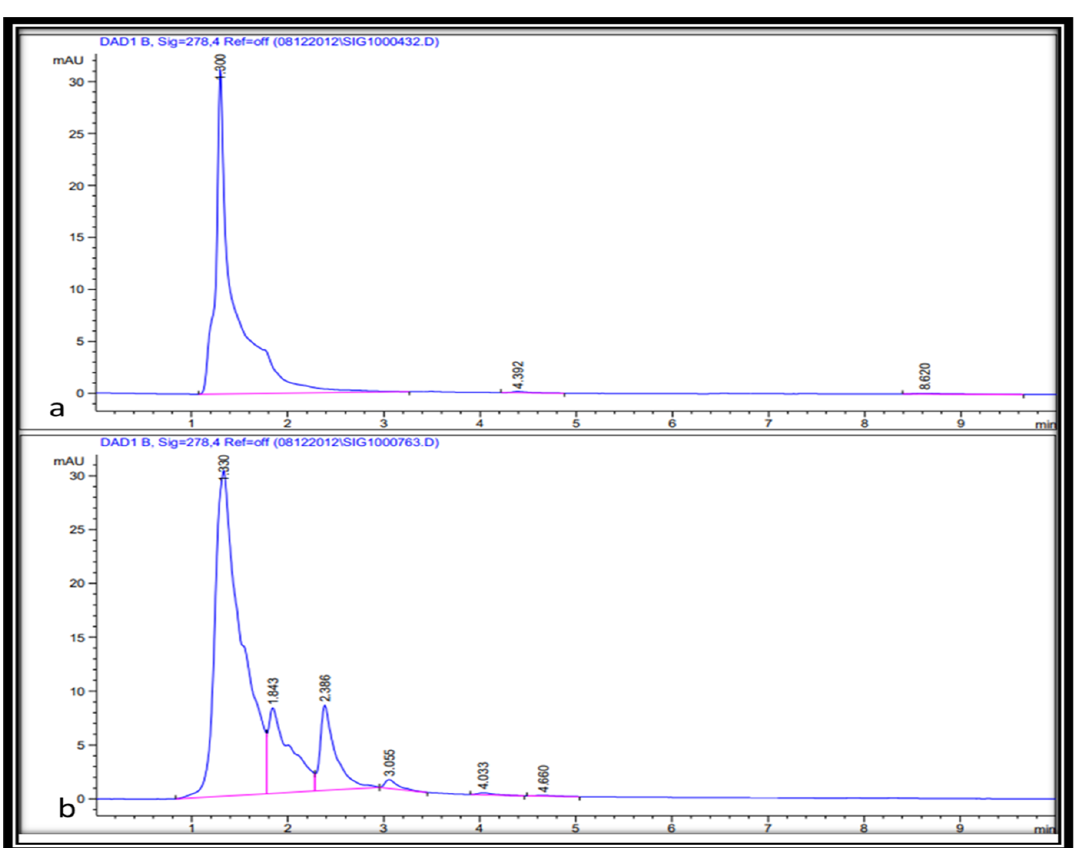
Figure 3. ( a ) HPLC chromatogram of the quercetin standard (at 278 nm). ( b ) HPLC chromatogram of the flavonoid compound in the plant extract (at 278 nm) shows a retention time at 1.3 min.